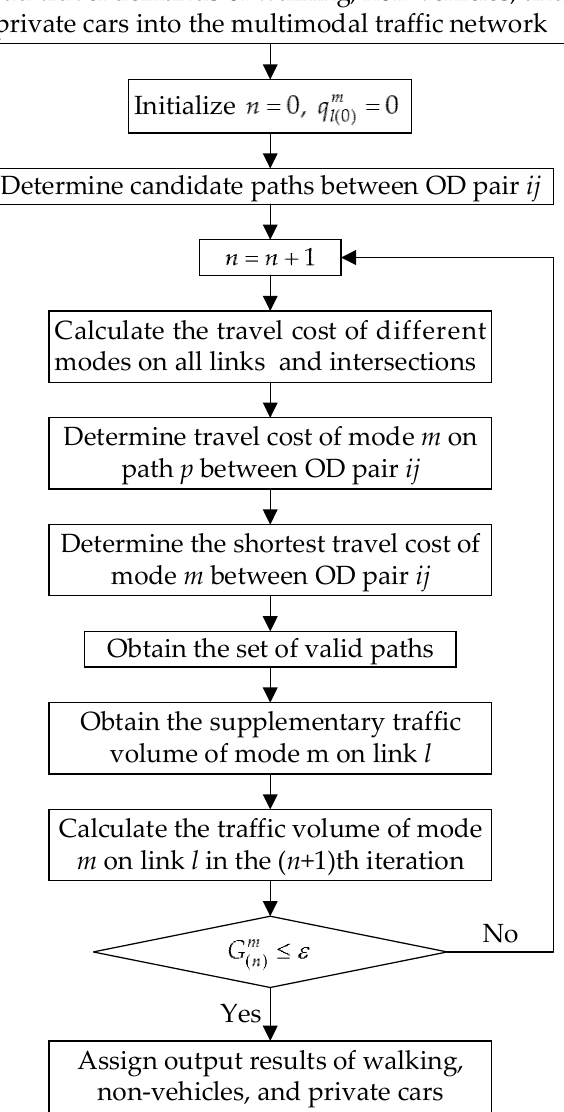
Figure 1. Flow chart of MSWA.